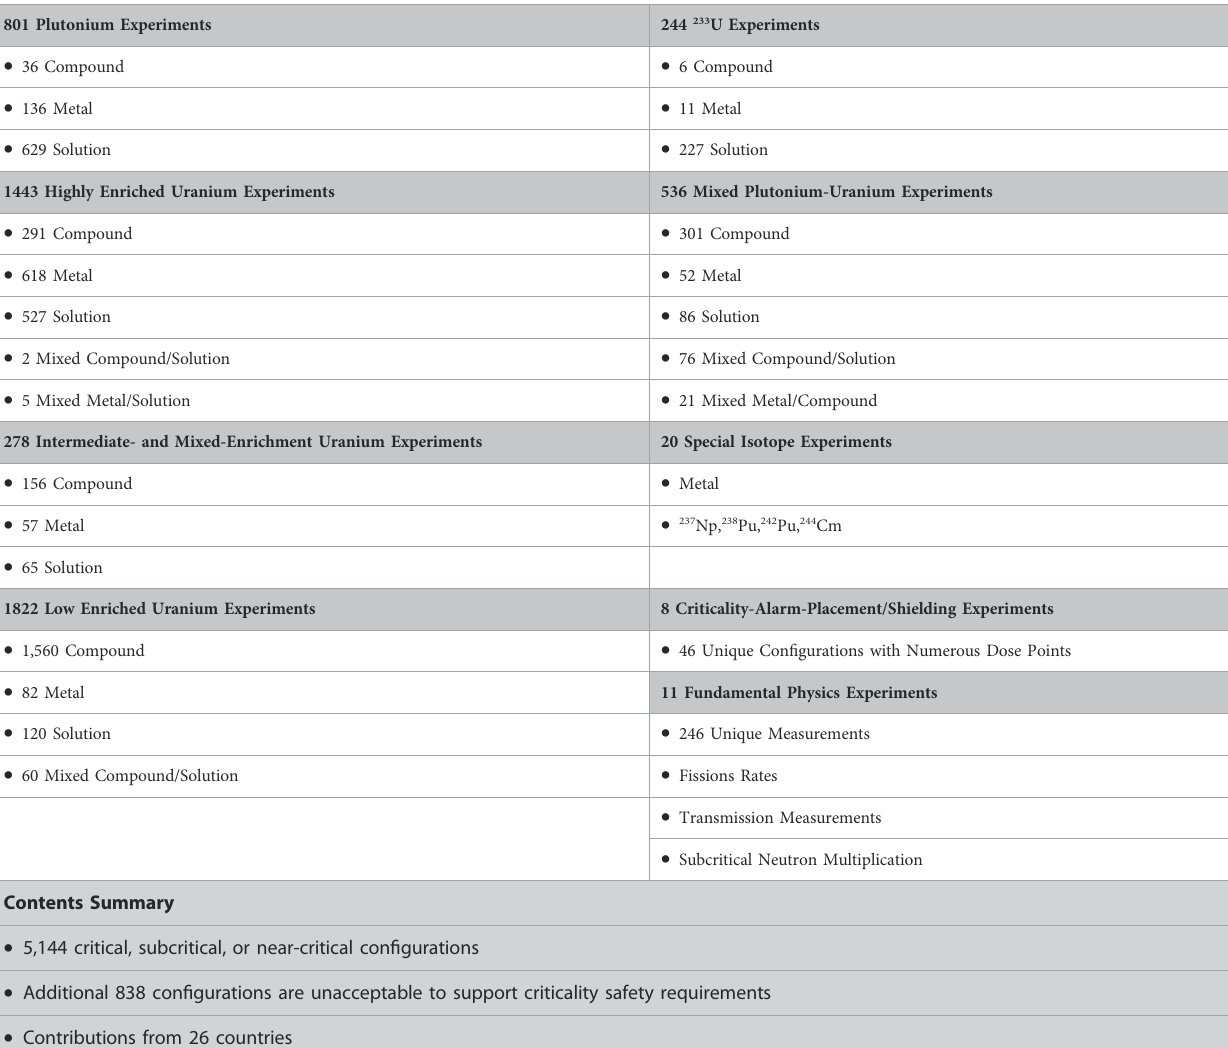
TABLE 1 Contents summary for the 2022 edition of the ICSBEP